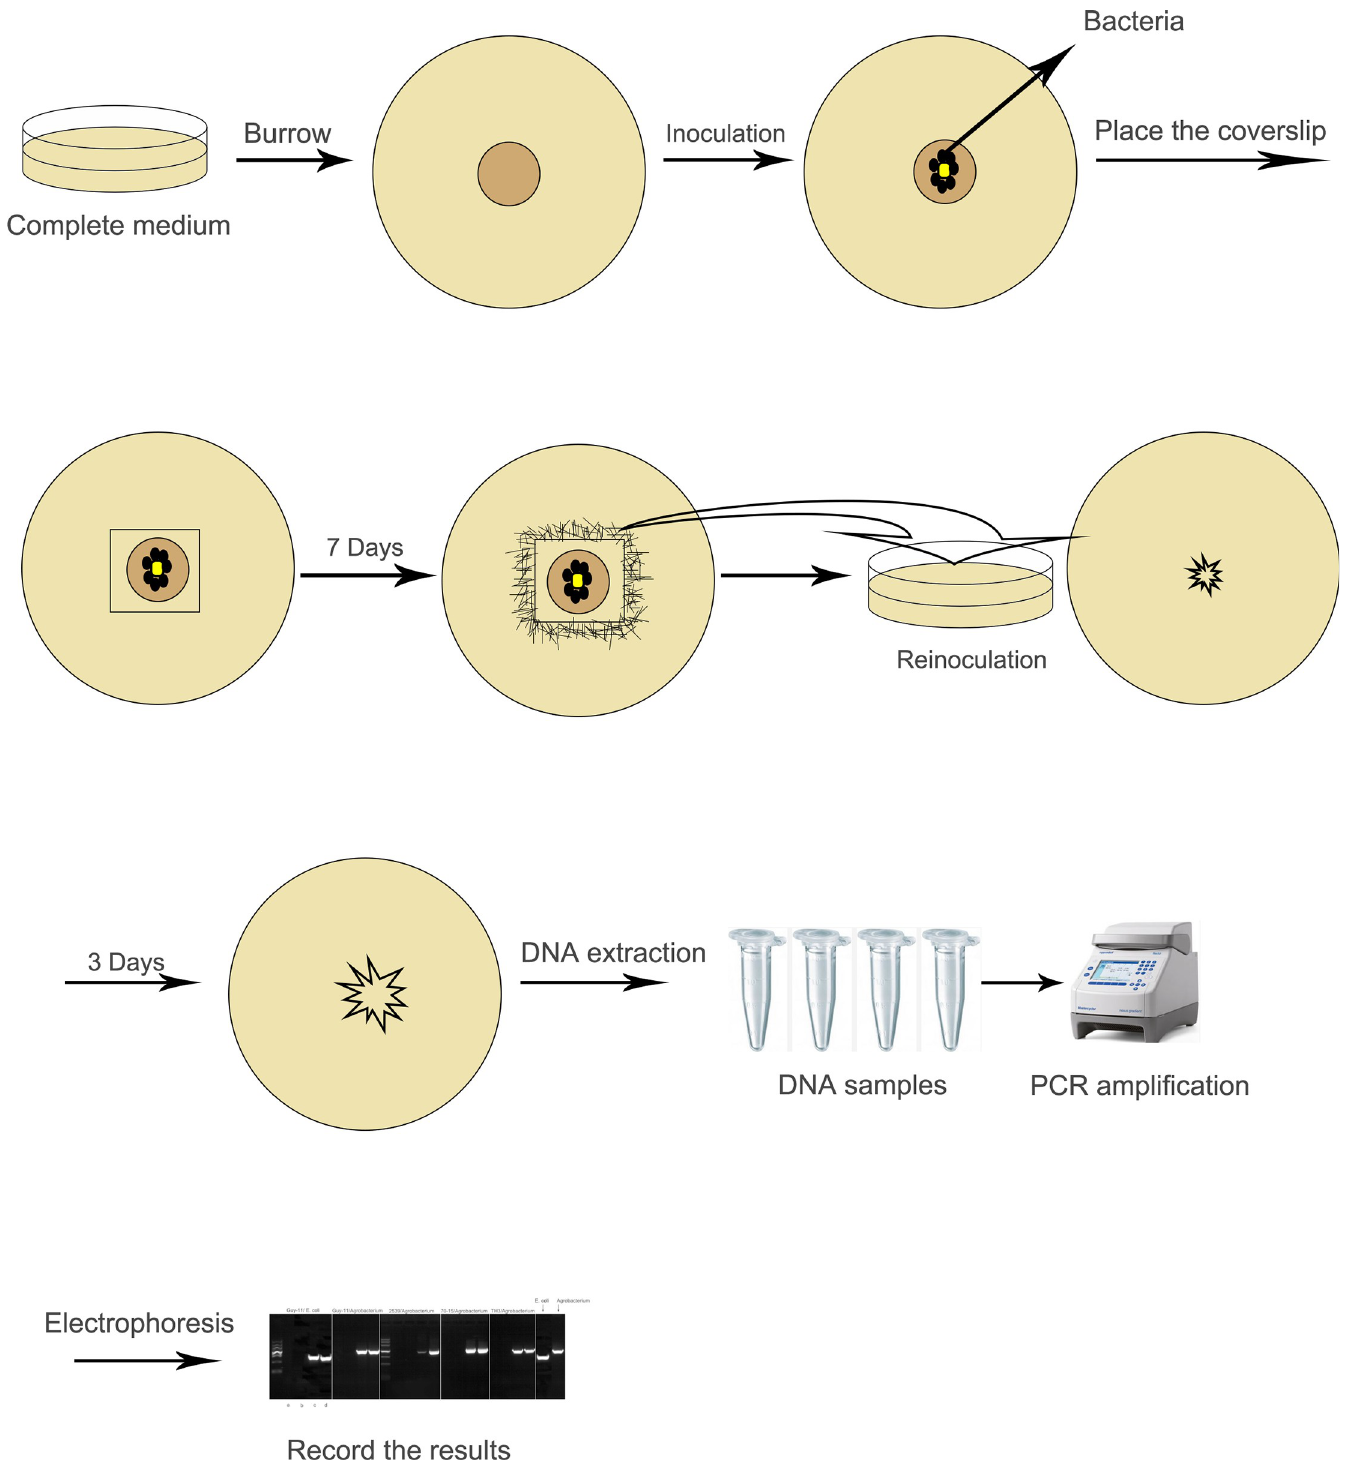
Fig 1. Fungal culture plates with bacterial contaminations. Some common bacterial contaminations during culturing Magnaporthe oryzae Guy-11 strains on complete medium plates.